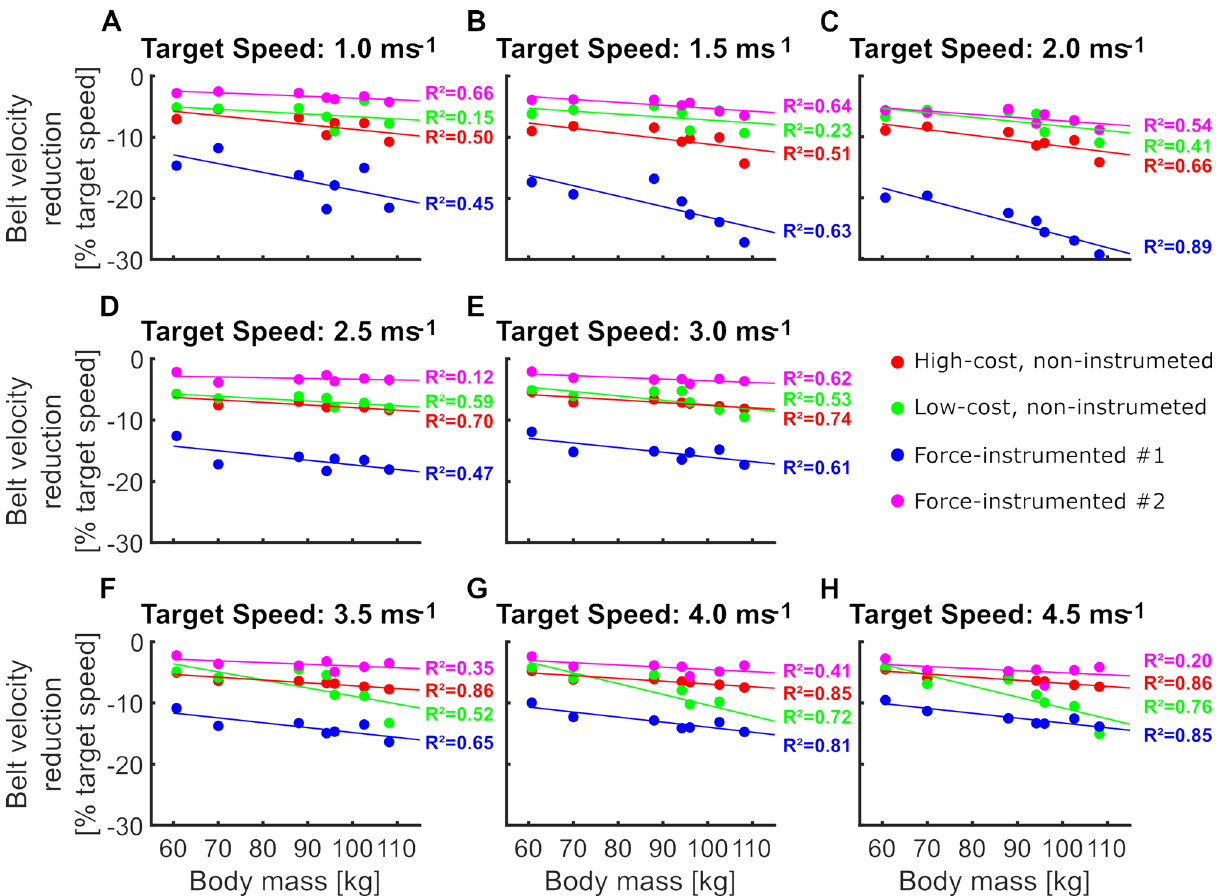
Figure 6. The relationship between the participants’ body mass and treadmill belt velocity reductions during the braking phase of stance at different walking ( A – C ) and running ( D – H ) speeds. Each dot represents the result of one particular participant, while colors differentiate between treadmill types. Colored lines were fitted using linear least squares